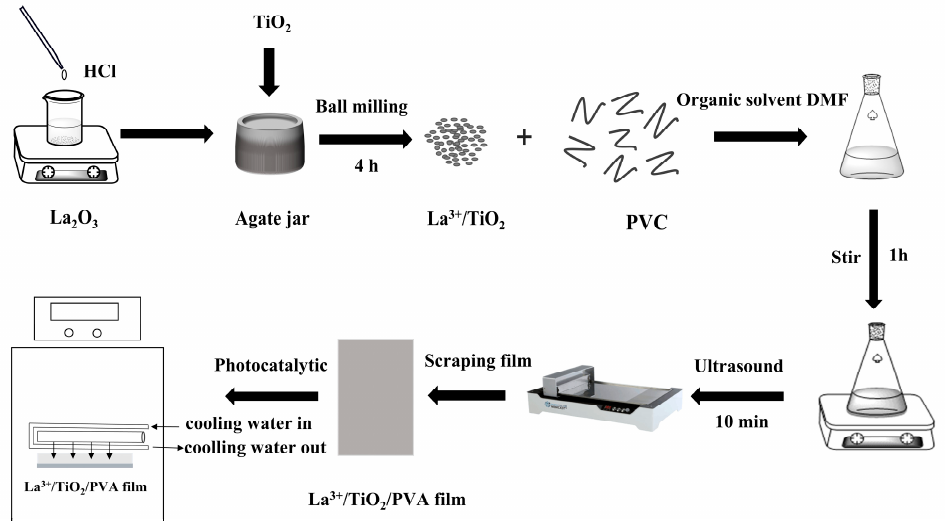
Figure 1. Preparation process of La 3+ /TiO 2 /PVC composite film by using La 3+ /TiO 2 photocatalyst and the schematic diagram of the photodegradation equipment.